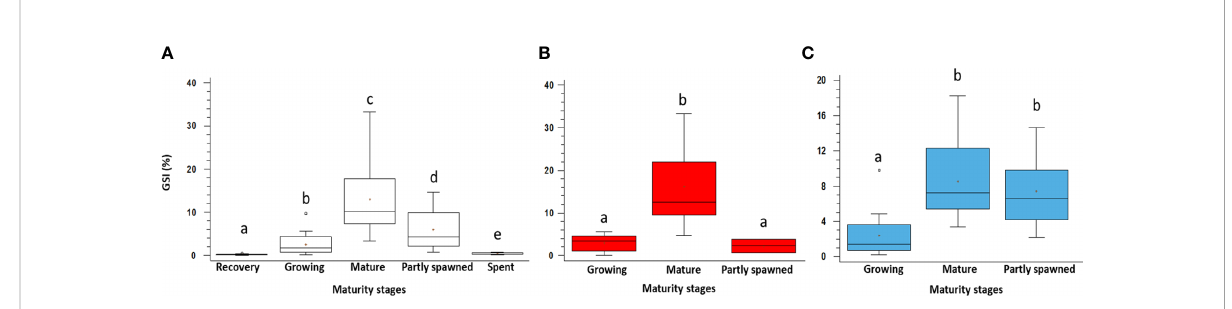
FIGURE 5 GSI variation among different maturity stages of the gonads in Holothuria tubulosa specimens. In (A) whole sample showing all the maturity stages; (B) females; (C) males. Lowercase letters indicate the results of the post-hoc tests. The boxes show the interquartile range, with the median value indicated by the horizontal line and the ‘ + ’ sign indicating the mean; whiskers show the range. Individual symbols show